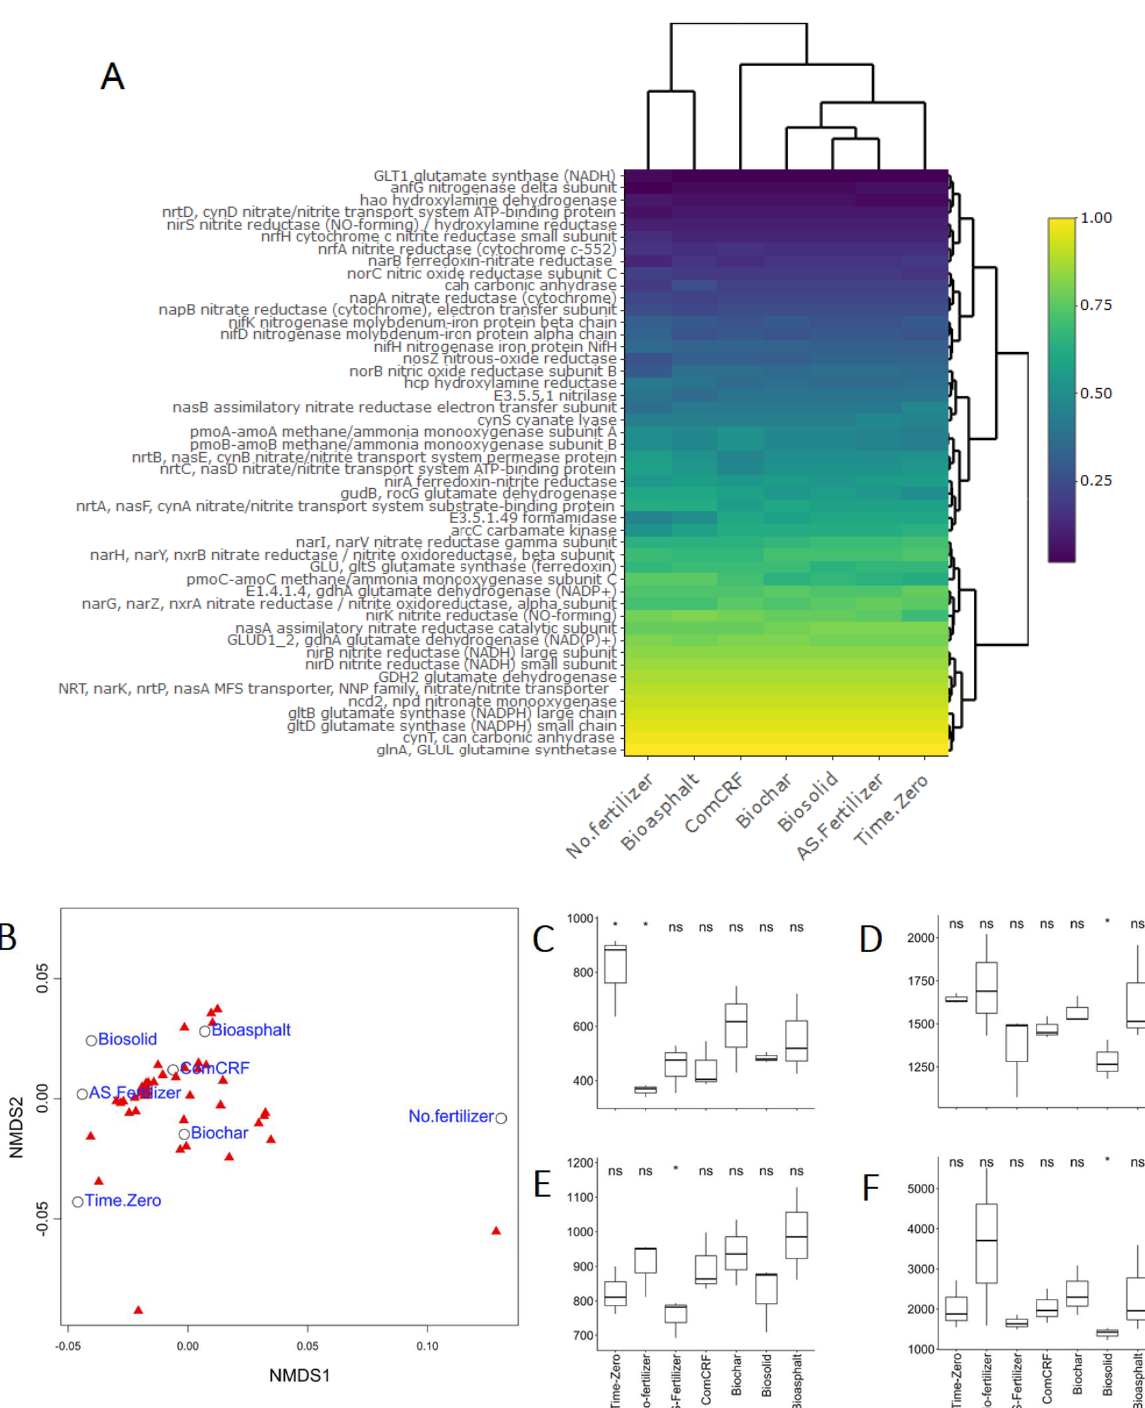
Figure 5. Functional predictions of bacterial gene associated with the nitrogen cycle. Heatmap showing N-cycle functional predictions using “ hclust ” algorithm across the treatments ( A ); Non-metric Dimensional Scaling (NMDS) showing the distribution of treatments ( B ); N-cycle functional potential in the treatments by specific gene functions, ferredoxin-nitrate reductase ( narB ) [EC:1.7.7.2] ( C ); nitrous-oxide reductase ( nosZ ) [EC:1.7.2.4] ( D ); carbonic anhydrase ( cah ) [EC:4.2.1.1] ( E ); and hydroxylamine reductase ( hcp ) [EC:1.7.99.1] ( F ). [* p < 0.05, ns = not